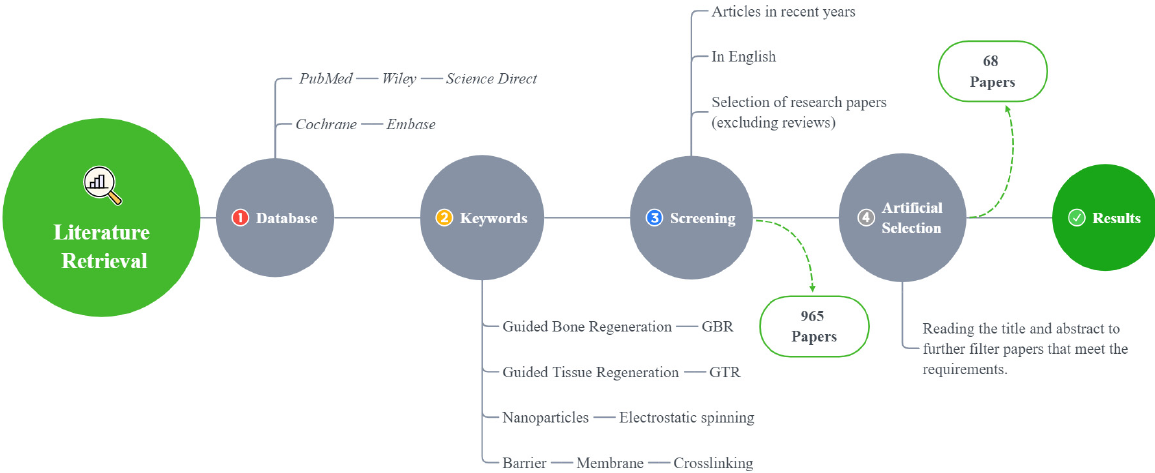
Figure 2. A flowchart of the literature search method.